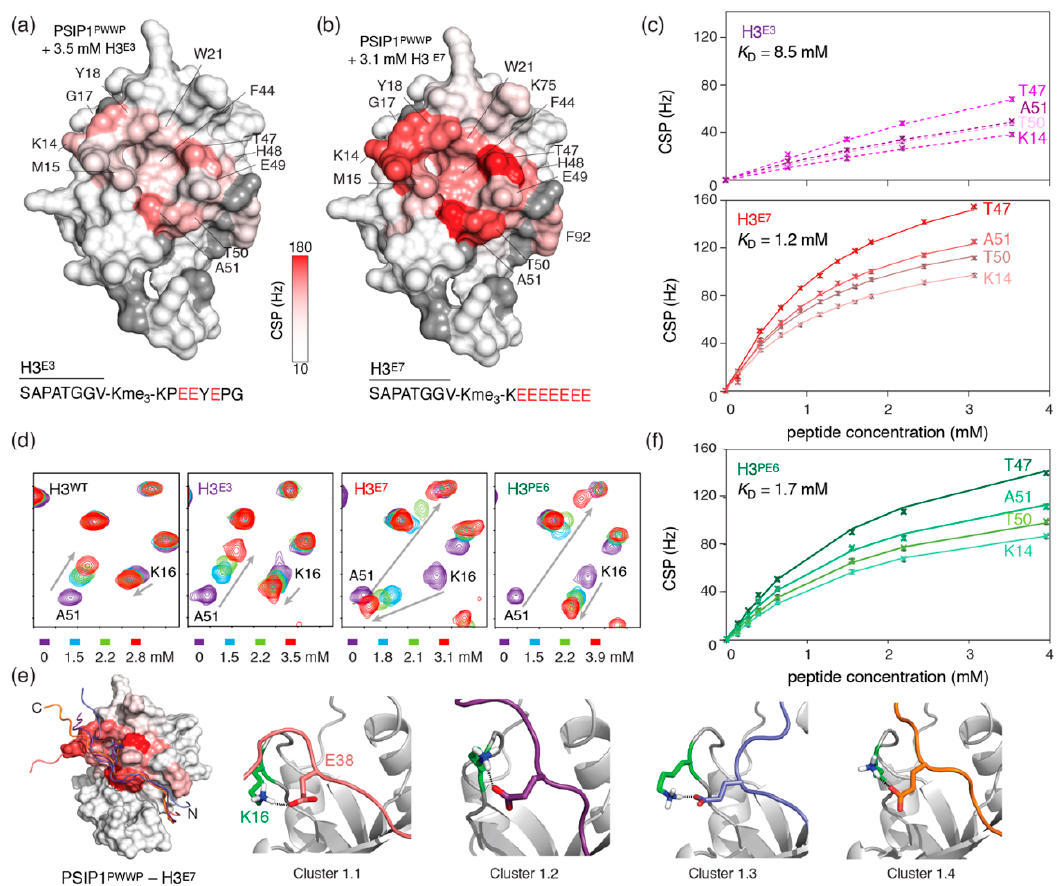
Figure 3. Glu-rich H3 peptides have increased affinity for PSIP1 PWWP . ( a , b ) Surface plot of PSIP1 PWWP with color coding of CSPs upon binding of H3 E3 ( a ) and H3 E7 ( b ) at the indicated peptide concentration, showing largest changes around the aromatic cage region. ( c ) NMR-derived binding curves for H3 E3 (top) and H3 E7 (bottom) with best fits (solid lines) for selected residues together with best-fit value for the K D using a 1:1 binding model global fit of all residues with significant CSP. Fits for H3 E3 are based on titration up to 8.28 mM peptide; full data are shown in Figure S2. ( d ) Zoom on peak trajectories for A51 and K16 in the H3 WT , H3 E3 , H3 E7 and H3 PE6 titrations, showing significantly increased CSP for K16 in the H3 E7 titration. Tic marks are placed each 0.05 / 0.5 ppm in the 1 H / 15 N dimension. ( e ) Structural models of H3 E7 bound to PSIP1 PWWP , showing top four structures overlaid (left) and zoomed in on a conserved hydrogen bond between residues K16 (PSIP1 PWWP ) and E38 (H3 E7 ) (right). ( f ) NMR-derived binding curves for H3 PE6 with best fits (solid lines) for selected residues together with best-fit value for the K D using a 1:1 binding model global fit of all residues with significant CSP. Fits are based on titration up to 5.5 mM peptide; full data are shown in Figure S2. The plotted binding curves in panels c and f were derived from the CSPs in the 1 H dimension.